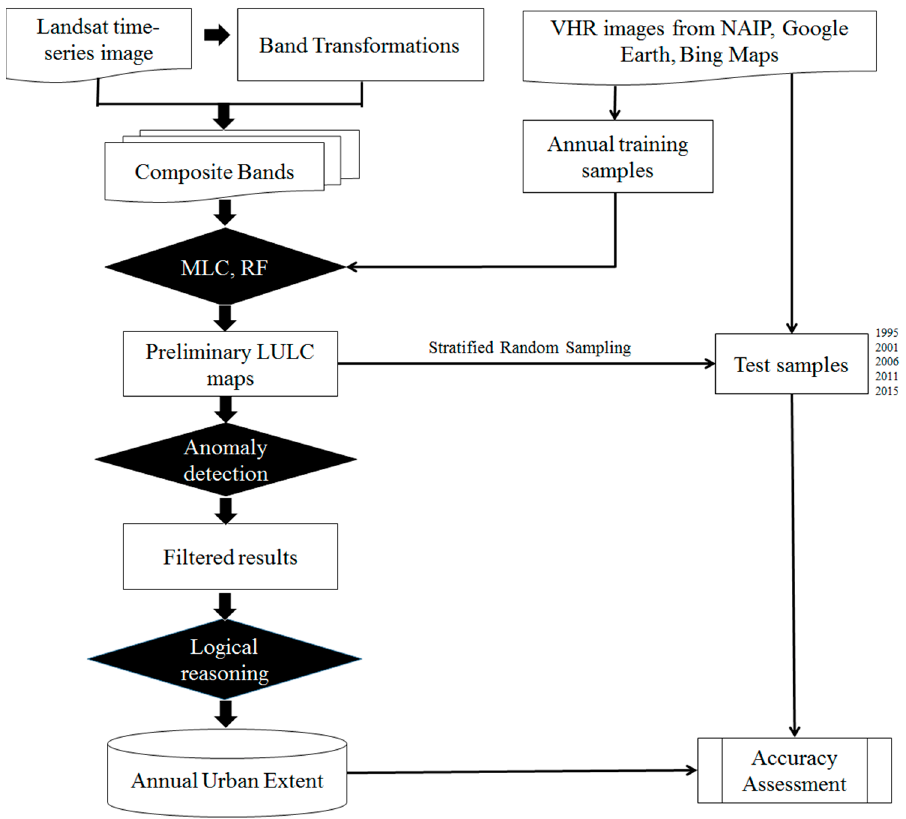
Figure 2. The classification workflow. VHR—very high resolution; NAIP—National Agriculture Imagery Program; MLC—Maximum Likelihood Classifier; RF—Random Forest classifier; LULC—land use and land cover.